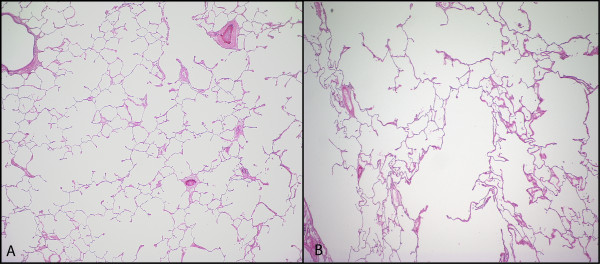
Heterogeneity of Lung Tissue Destruction. Examples of hematoxylin and eosin-stained images of tissue samples taken from the same individual but different lung regions. A: Normal tissue with SA/V = 439 cm2/cm3, tissue density = 0.19 g/ml, B: emphysematous tissue with SA/V = 183 cm2/cm3, tissue density = 0.14 g/ml.